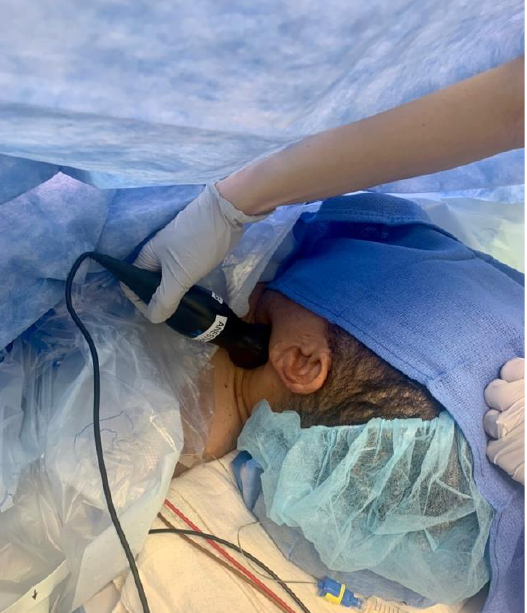
Figure 1. Intraoperative assessment of carotid blood flow performed using a portable handheld ultrasound device (Butterfly iQ) at a patient’s left carotid artery. The handheld device is placed on the patient’s neck, and the carotid artery is identified in transverse section. The device is then rotated 90 degrees to longitudinally image the vessel and align the spectral Doppler in the direction of blood flow. Either the left or right carotid artery can be used, and serial measurements should utilize the same